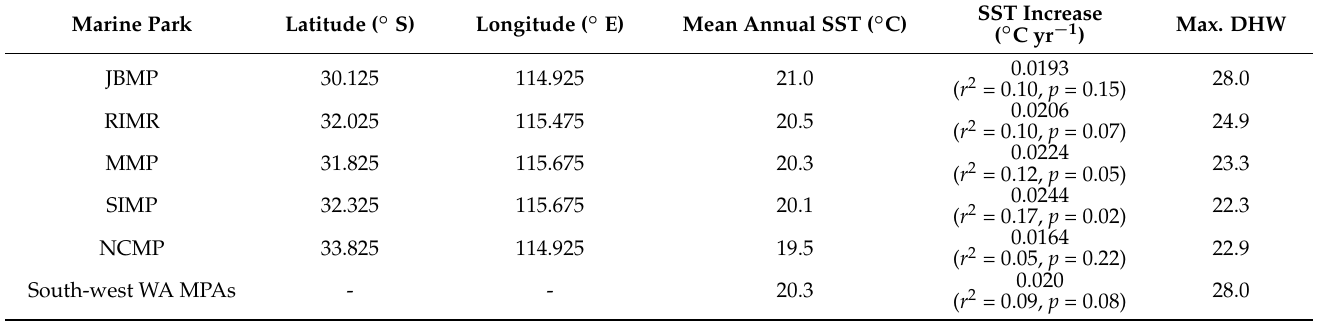
and 17.6–21.1 °C at NCMP with the monthly maximum typically occurring in March and the minimum in September (Figure 2). The maximum degree heating weeks (DHW) ranged from 22.9 to 28.0 and occurred during the 2011 La Niña marine heatwave and DHW were higher at the lower latitude locations (especially JBMP) and decreased with increasing latitude (Table 1). The annual rate of gradual warming varied between marine parks, with an increase in summertime (March) SST occurring at a rate of 0.0164 yr − 1 at the NCMP located at higher latitude and a rate of 0.0193 yr − 1 at JBMP located at a lower lati- tude (Figure 3; Table 1).